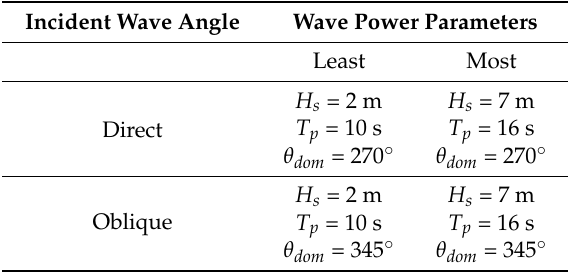
Table 5. Wave conditions for forcing numerical